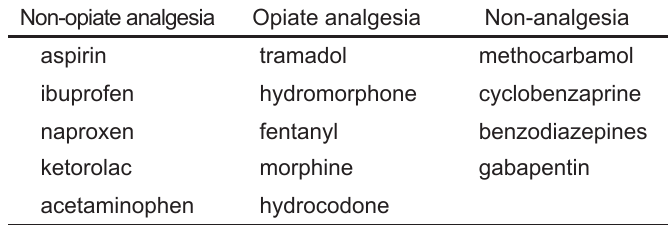
Table 1. Non-opiate analgesia, opiate analgesia, and notable non- analgesia